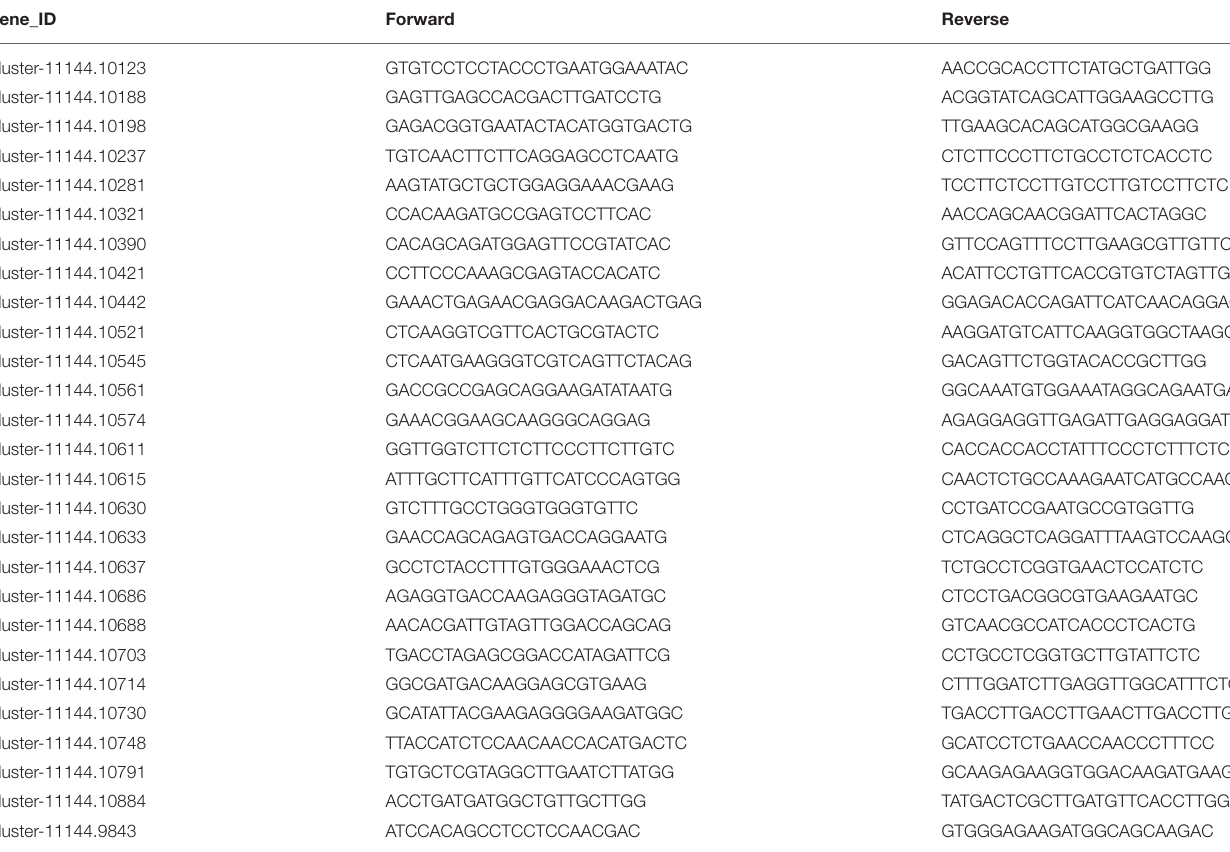
TABLE 1 | Sequences of the specific primers for the genes tested in real-time PCR